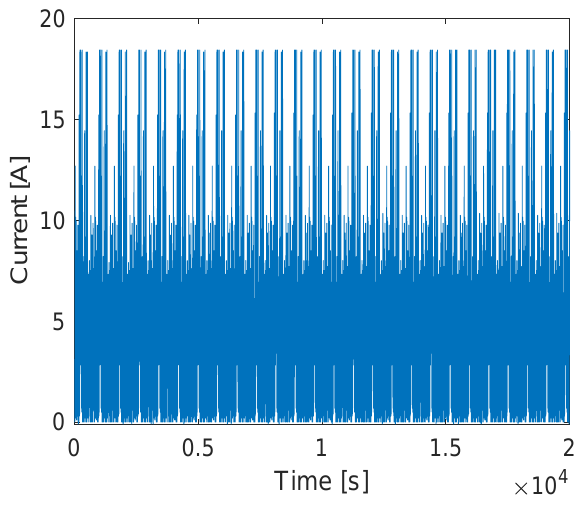
Figure 3. Applied current